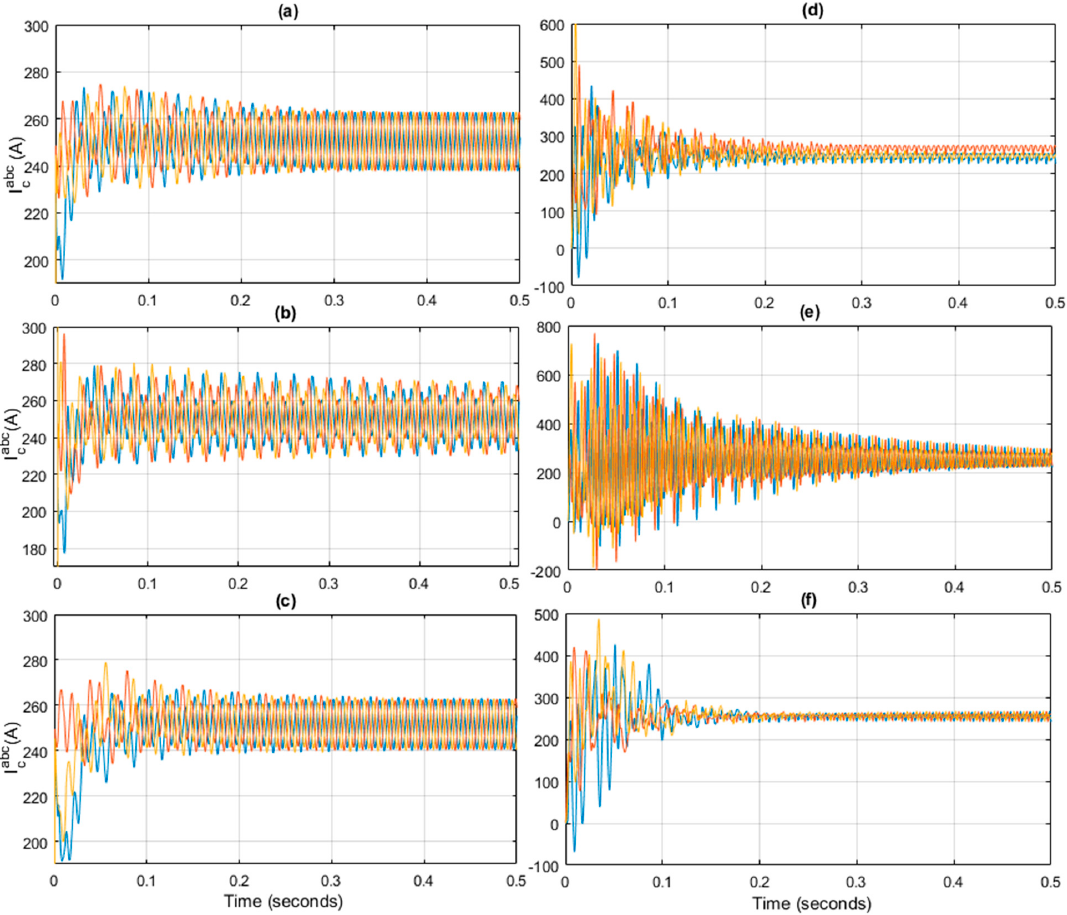
Figure 10. Circulating current at ( a ) L = 50 mH in case of proposed controller; ( b ) L = 25 mH in case of proposed controller; ( c ) L = 100 mH in case of proposed controller; ( d ) Nominal value of Inductor in case of the PR; ( e ) L = 25 mH in case of the PR; ( f ) L = 100 mH of nominal inductor value in case of the PR.